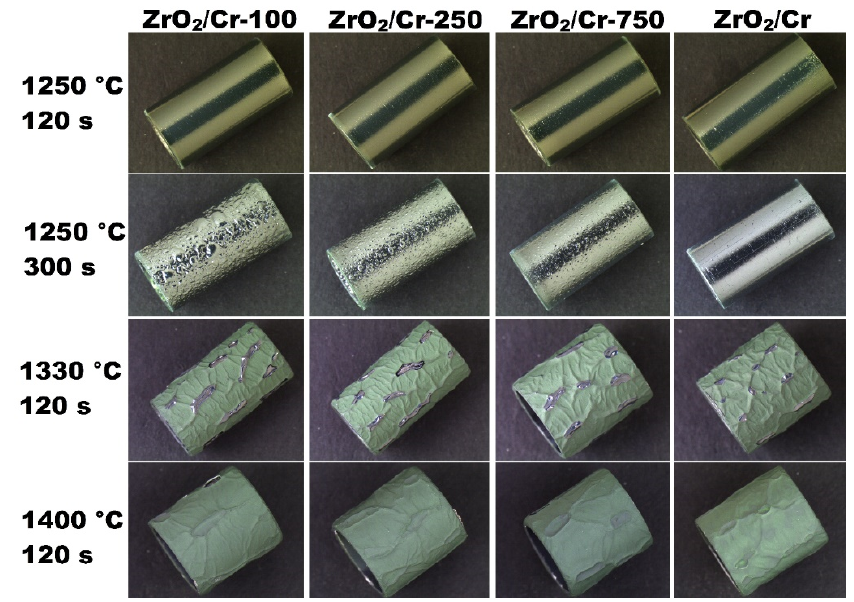
Figure 10. Appearance of the samples after steam oxidation at 1250, 1330, and 1400 °C for 120 and 300 s. 300